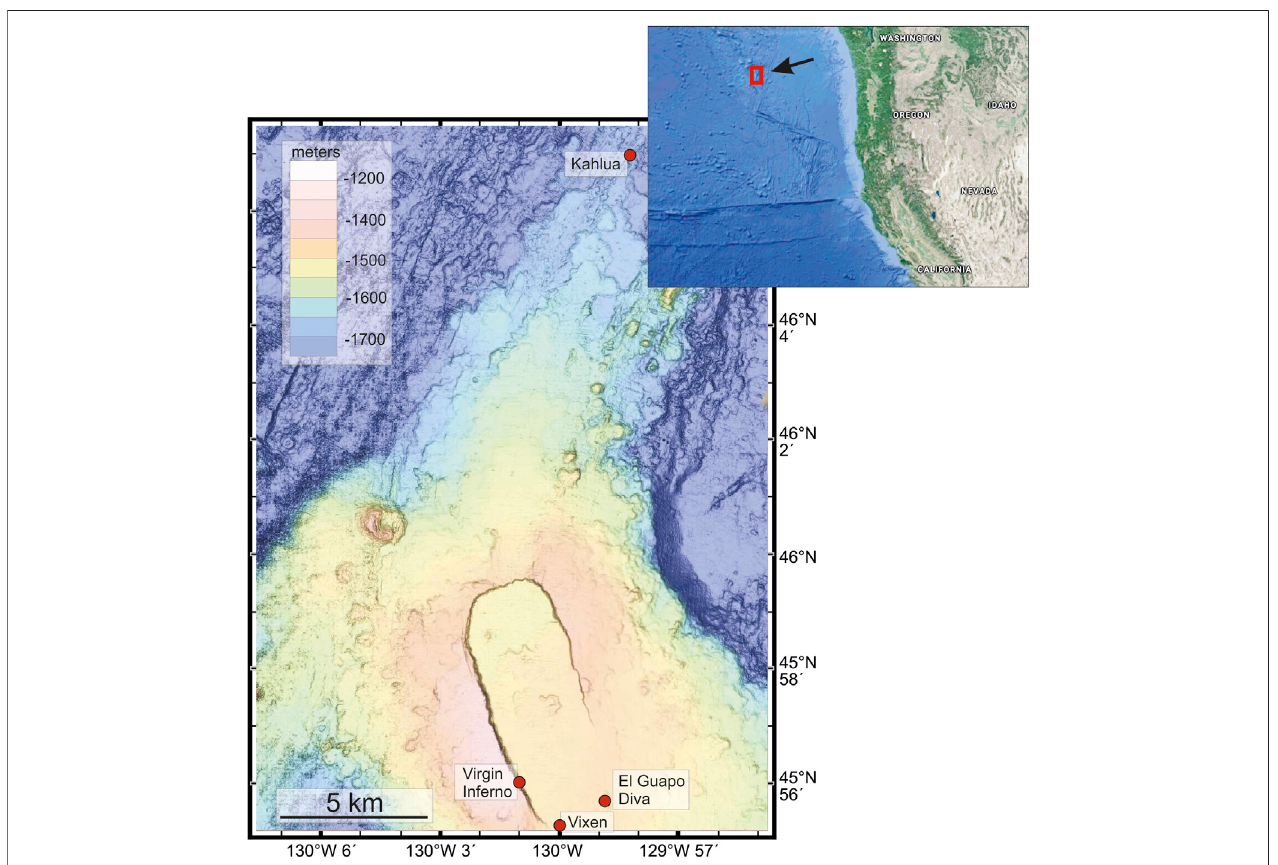
FIGURE 1 | The location of the Axial Seamount volcano on the Juan de Fuca ridge of the cost of the western U.S. is shown in the inset. The bathymetry map (Wilcock et al., 2018) of the caldera is shown with the location of the vent sites used in this study. The vent fl uids from sites Virgin, Inferno, Vixen, El Guapo, and Diva are presented in this paper. The Kahlua vent fl uids are not presented in this